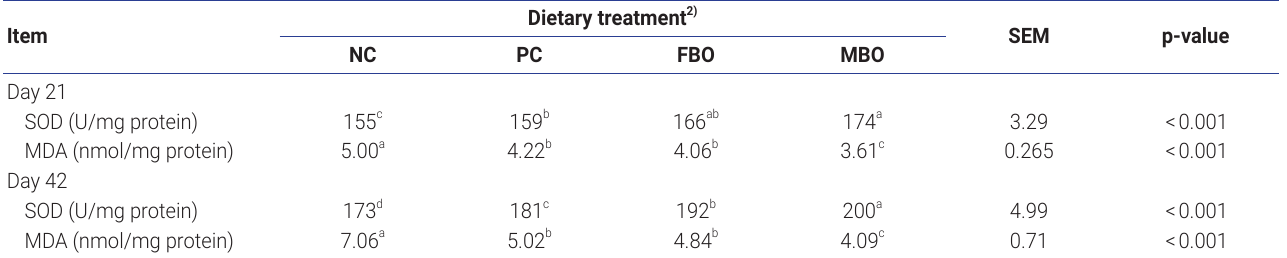
Dietary treatment